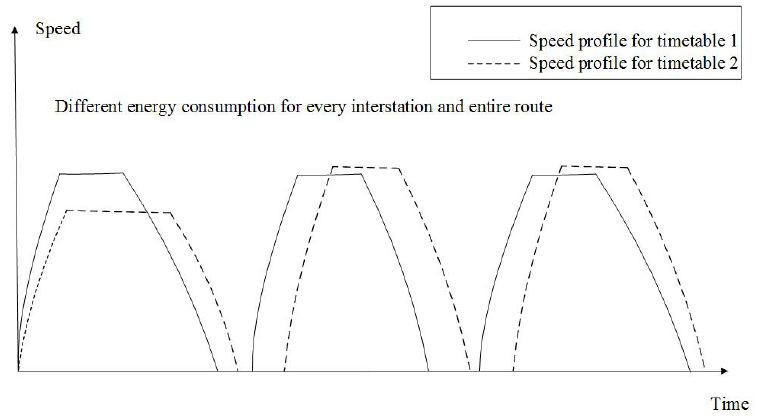
Figure 1. Different timetables for multiple